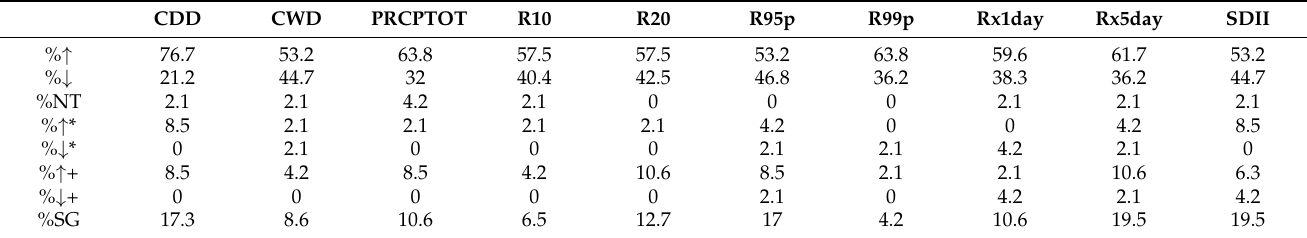
Table 4. A summary of trend results for extreme rainfall indices in